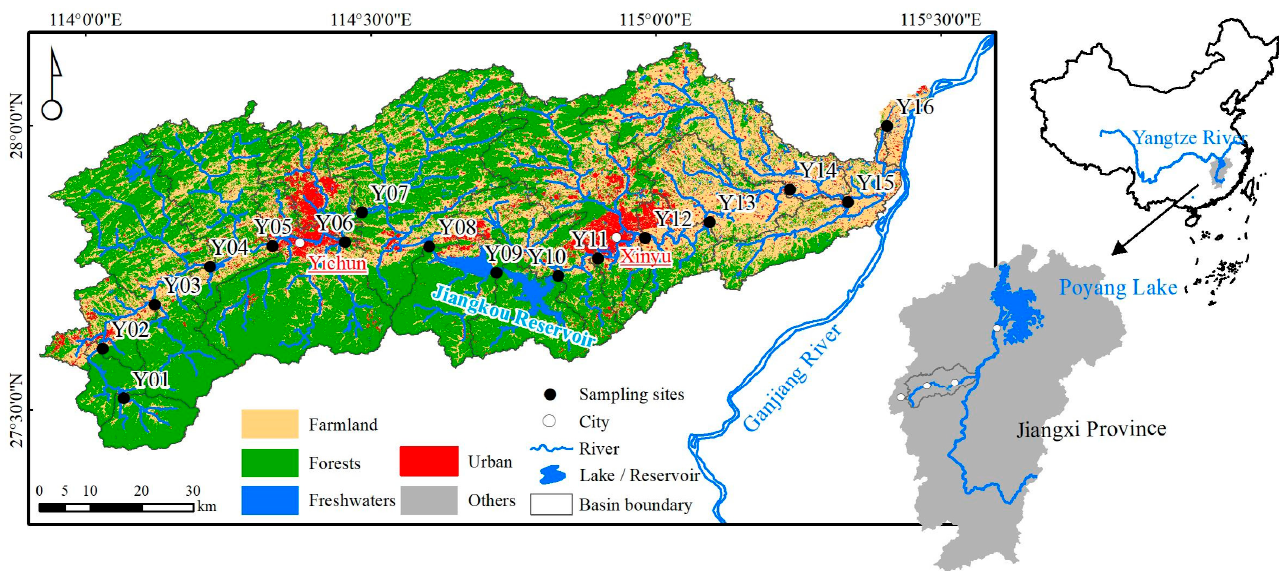
Figure 1. Map of the Yuan River and sampling sites. The cities of Pingxiang, Yichun, and Xinyu are located upstream and downstream in the Yuan River basin.